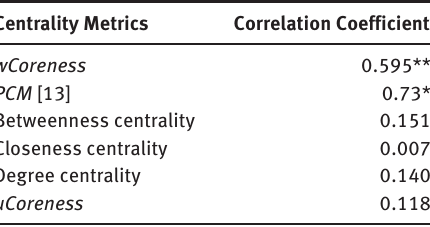
Table 9. Spearman’s Correlation Test